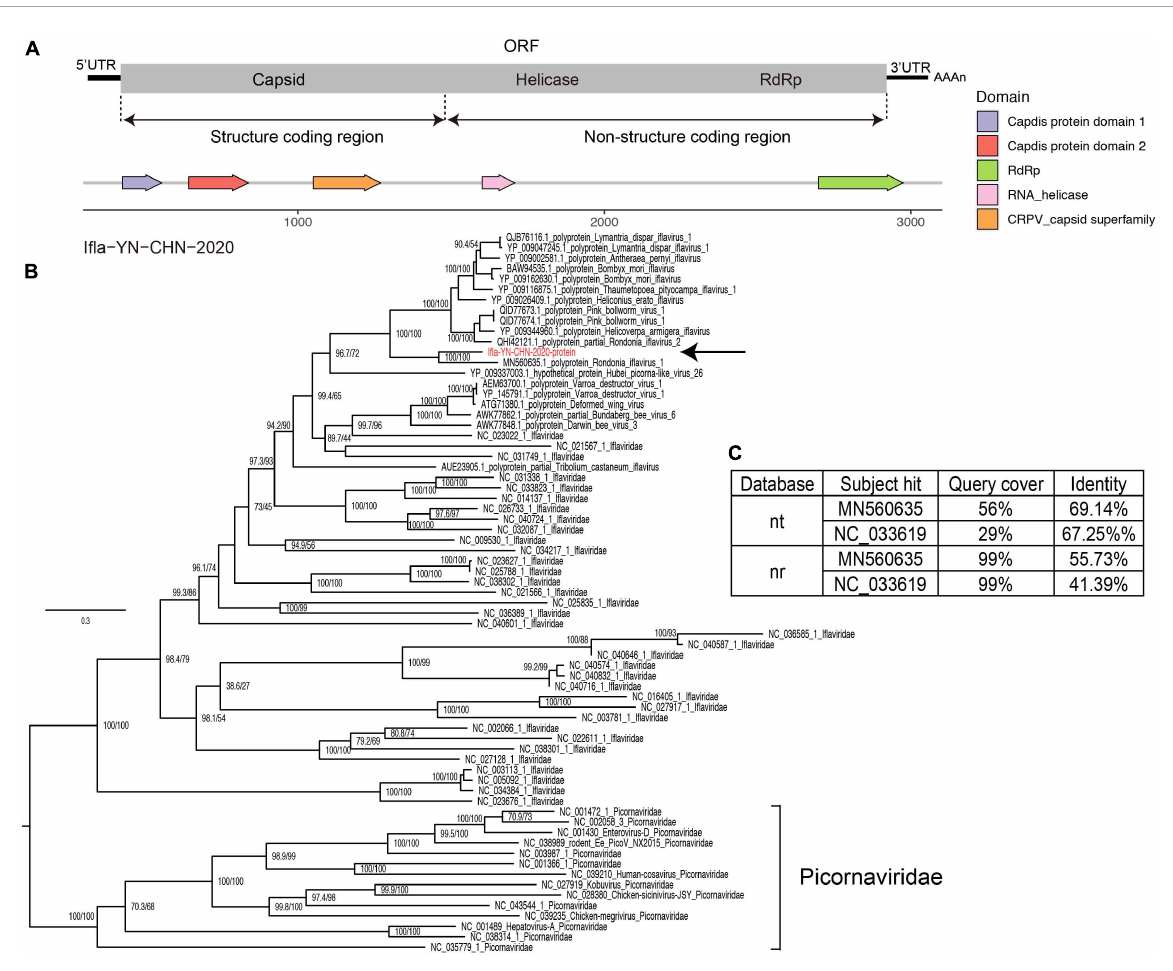
FIGURE5 Characterization of iflavirus genome contigs. (A) Genomic organization of the detected iflaviruses and annotation of conserved domains. (B) Maximum likelihood tree of the complete amino acid sequences of the detected iflaviruses along with reference genomes of known species of Iflaviridae and neighboring strains. The scale bars show the substitutions per site per year, and the values at each node indicate the bootstrap and SH-like approximate likelihood ratio tests (SH-aLRT), with 1,000 bootstrap replicates. The black arrows represent the newly identified strains. Picornaviridae was used as an outgroup. (C) The top two hits in the nucleotide (NT) and protein (NR) databases obtained using BLASTN and